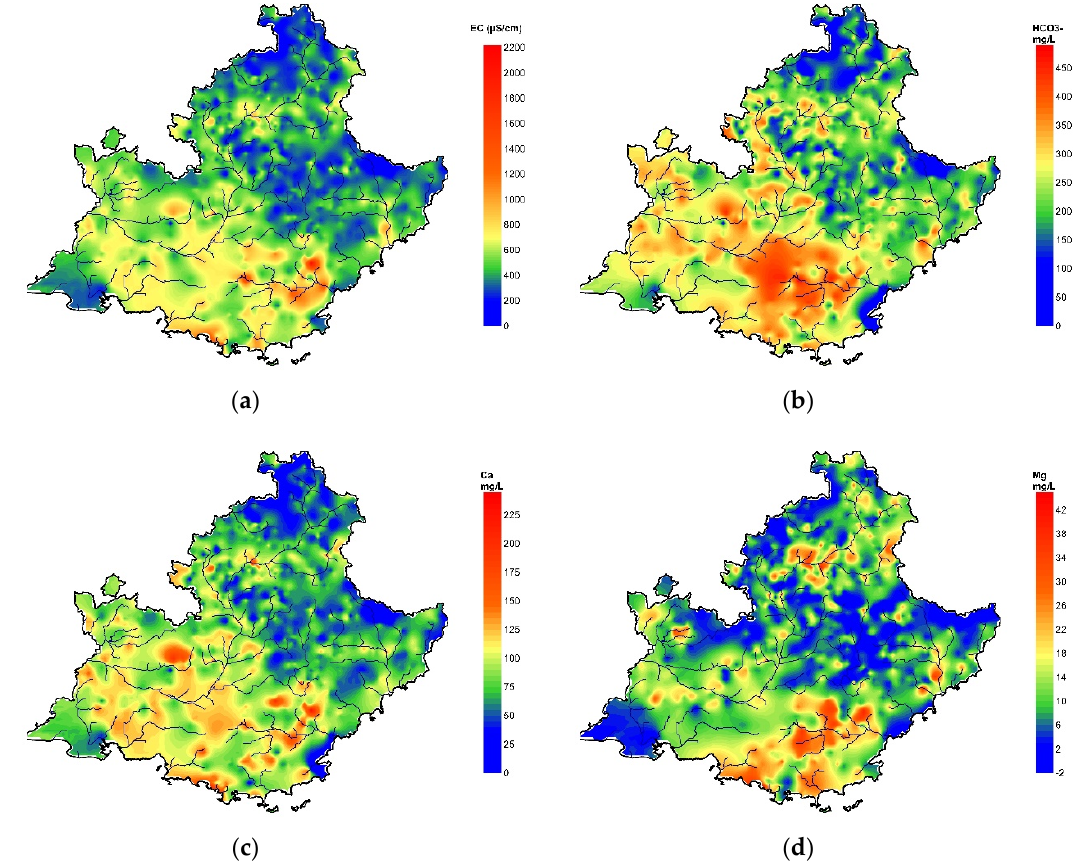
Figure 6. Distribution of the original variables ( a ) EC, ( b ) HCO 3 , ( c ) Ca and ( d ) Mg on the PACA region. Note a rather similar distribution of these parameters, which conveys redundant information. This redundancy is concentrated on the first principal component of the PCA (Figure 5a).